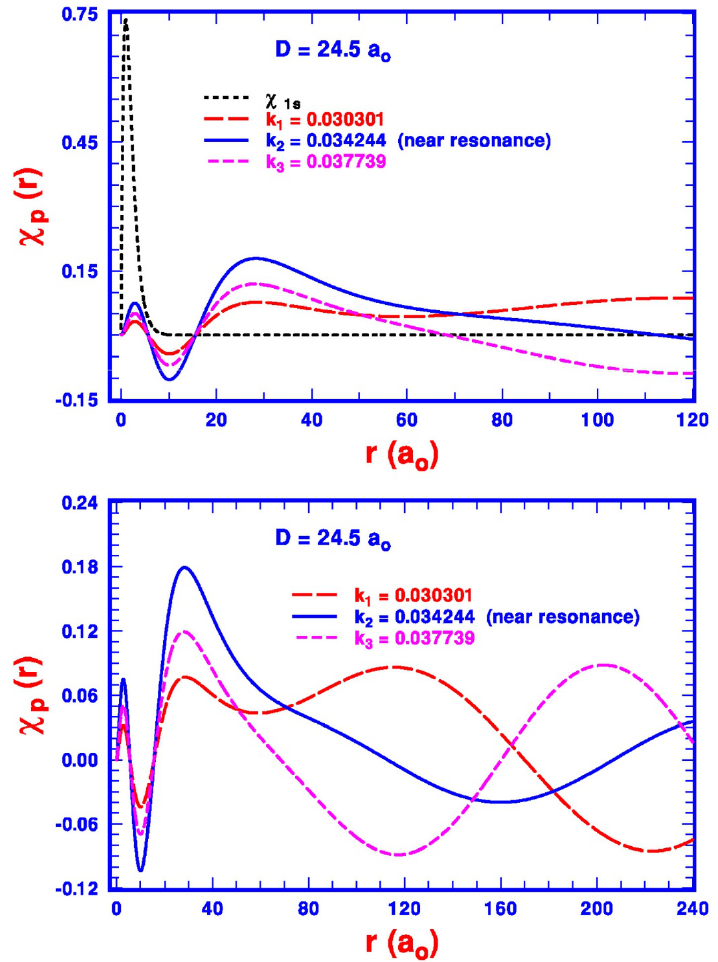
Figure 7. The top plot compares the radial functions χ kp of the outgoing ionized p electron to χ 1 s for hydrogen ground state photoabsorption subject to the outside plasma with D = 24.5 a o . The bottom figure shows an enlarged plot of χ kp with an expanded scale up to r = 240 a o